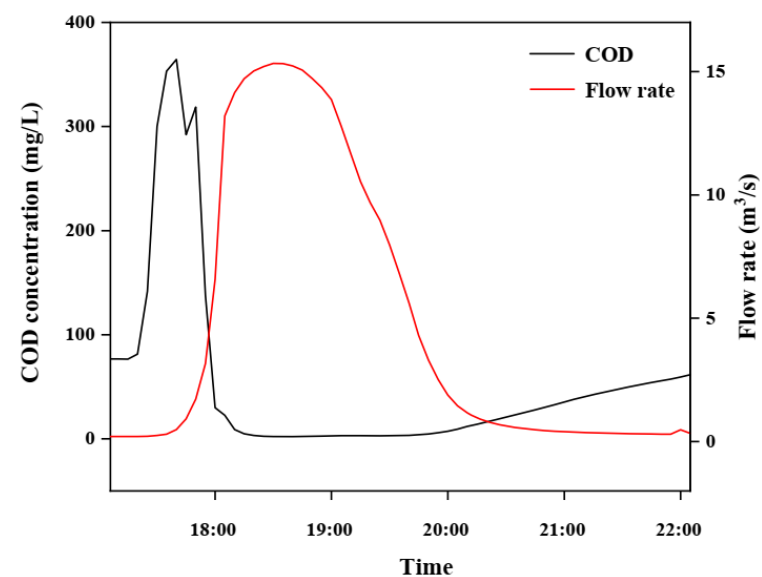
Figure 5. Discharge flow rate and chemical oxygen demand (COD) concentration of the simula- tion outfall.